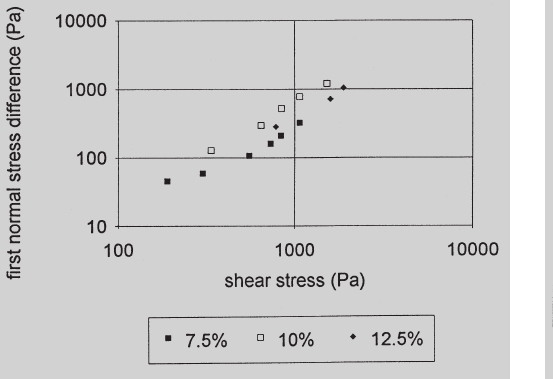
Figure 8 (left): Normal stress curves of Araldite GY 260 with different concentrations of Aerosil 380 (WRG, cone-plate 6°, 25°C). Figure 9: Viscosity curves of Aerosil 380 in Araldite GY 260 and Aerosil 380 in